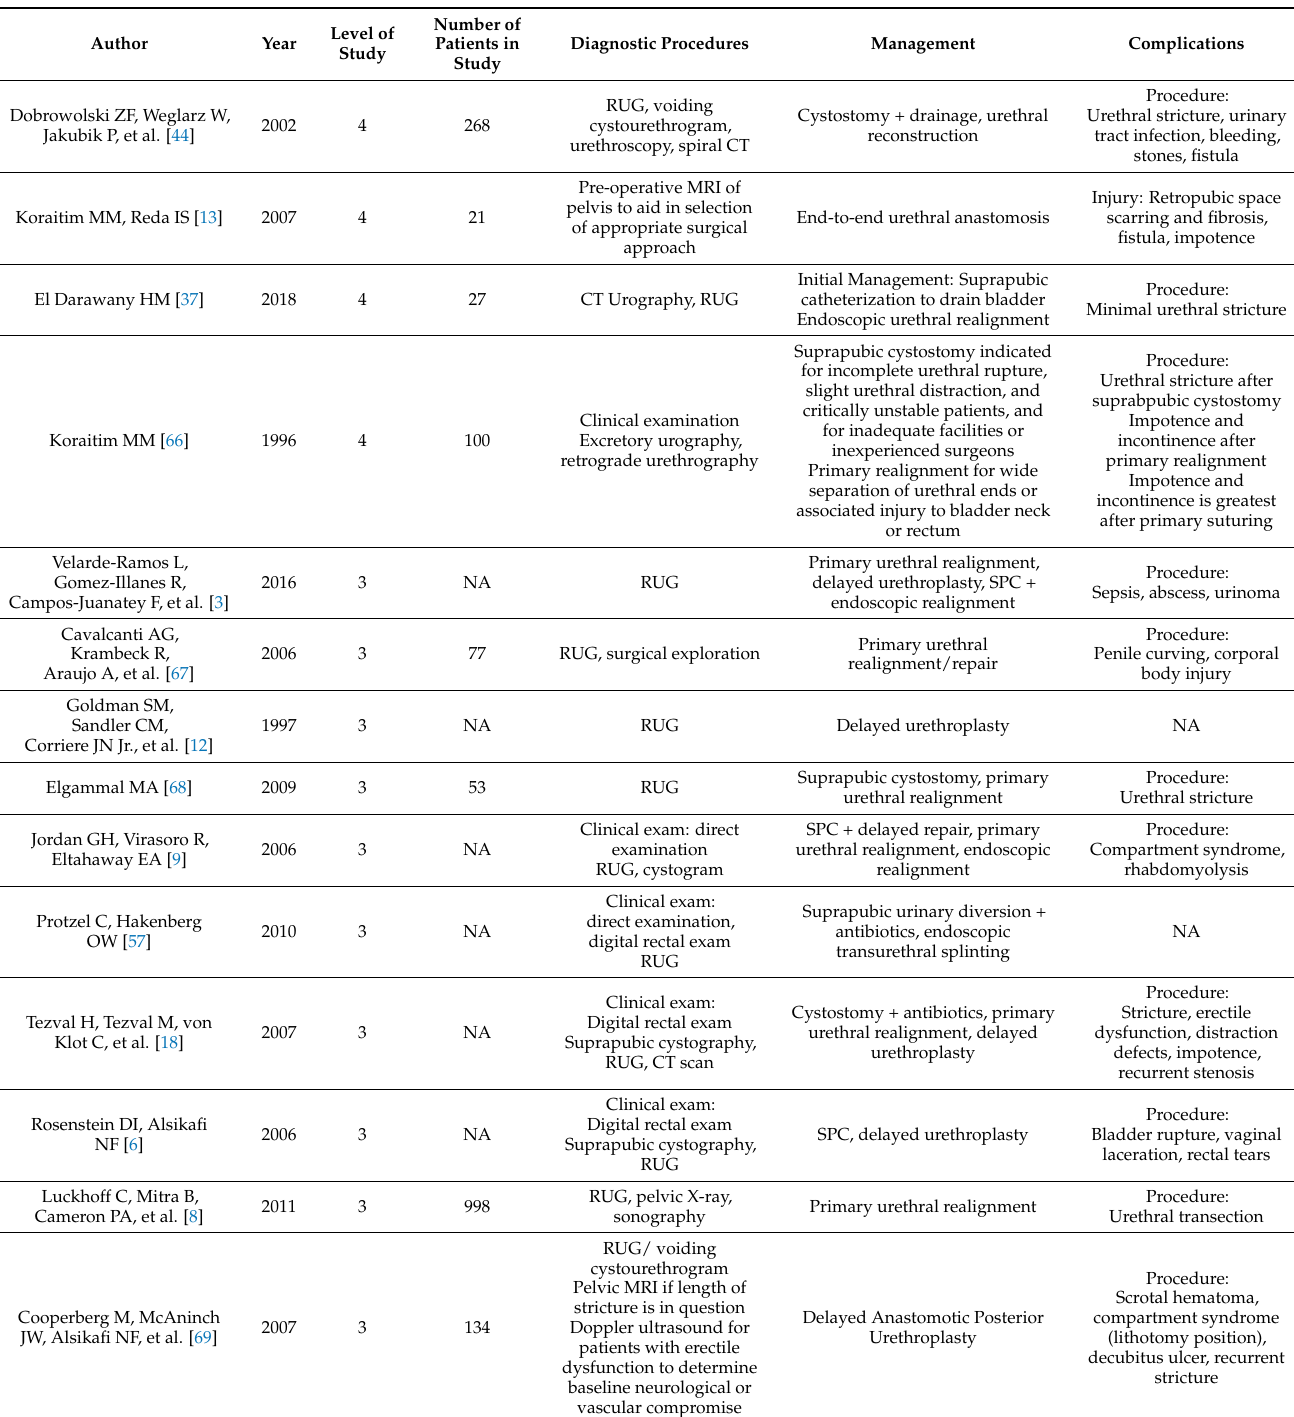
Table 5. Blunt Posterior Urethral